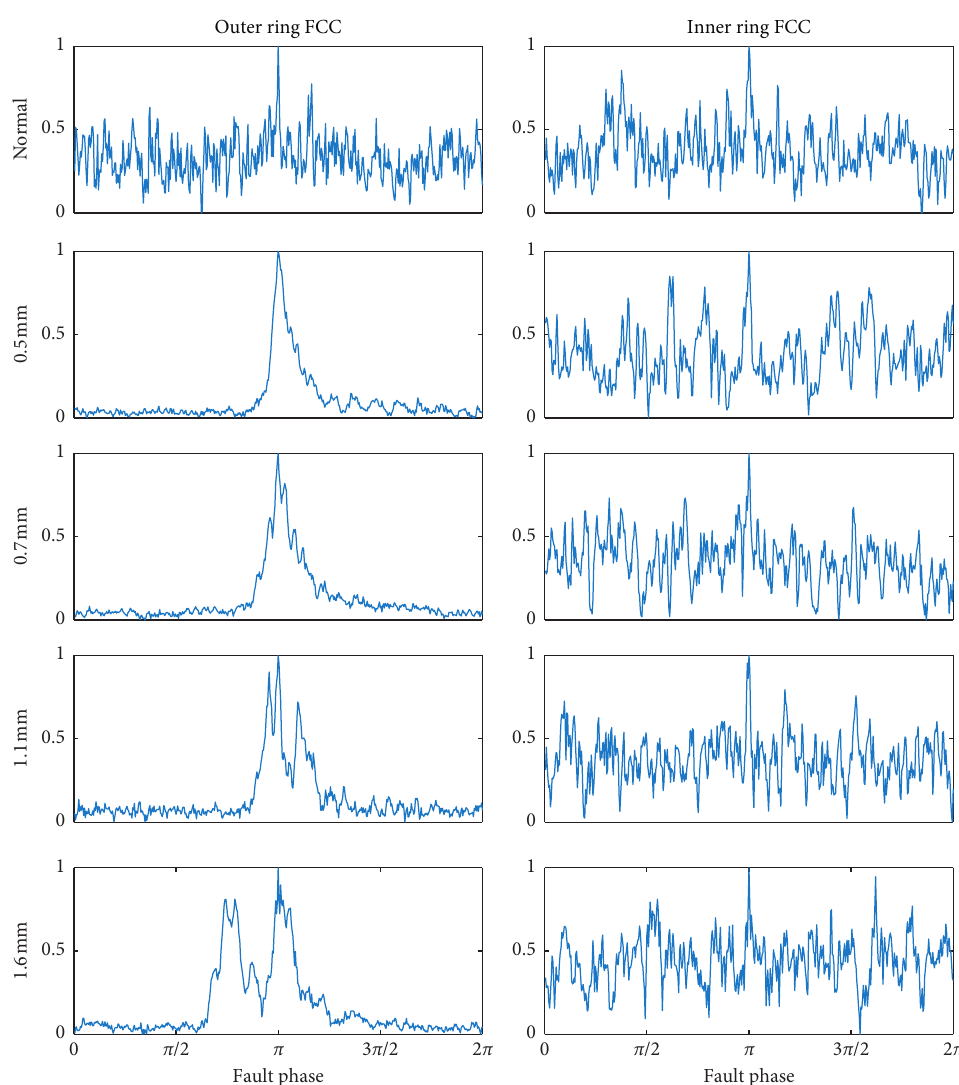
Figure 12: Outer ring fault feature extraction results under 4Hz and 2 kN